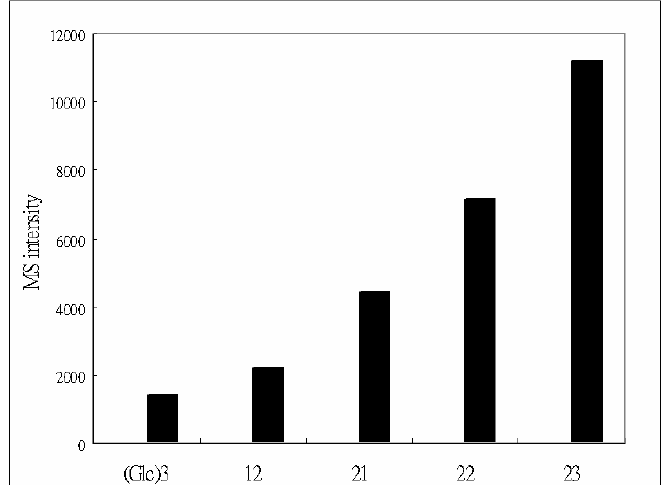
Figure 6. The comparison of mass indensity in MALDI-TOF MS with 2,5-DHB as matrix. , maltotrio-NAIM 12 and heteroatom The signal sensitivity of maltotriose (Glc) 3 derivatived maltotrio-imidazoles 21 , 22 , and 23 are shown. An 8 pmol of sample was deposited per spot. Spectra were obtained by accumulating 1000 laser shots. The matrix concentration was set at 50